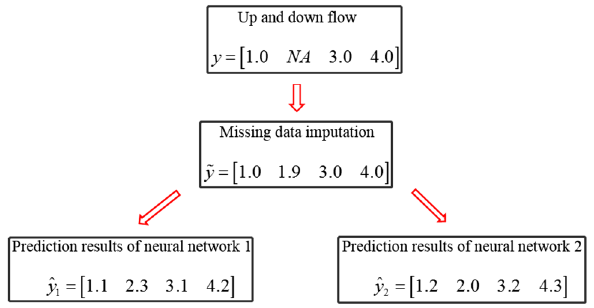
Fig. 6 An example comparing MSE and MSOE